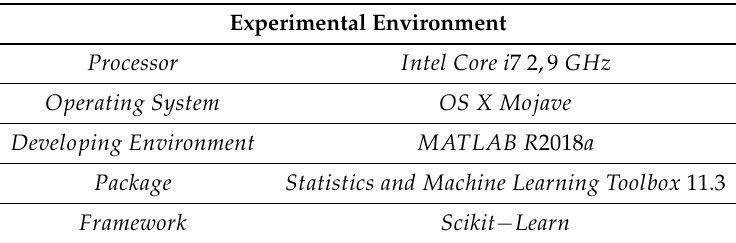
Table 1. Experimental environment and